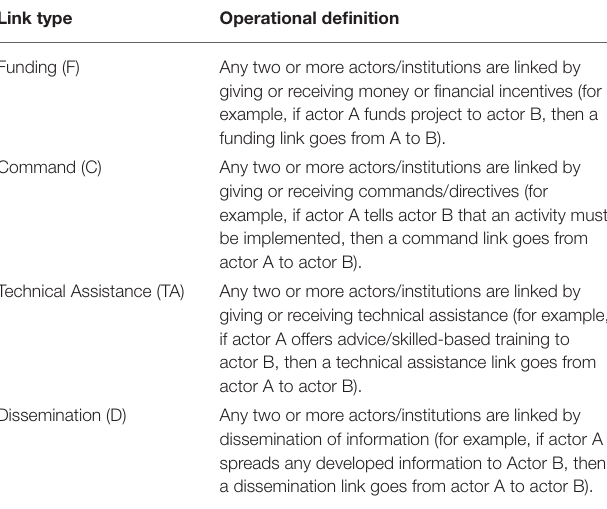
TABLE 3 | Description of links assessed in the Net-map